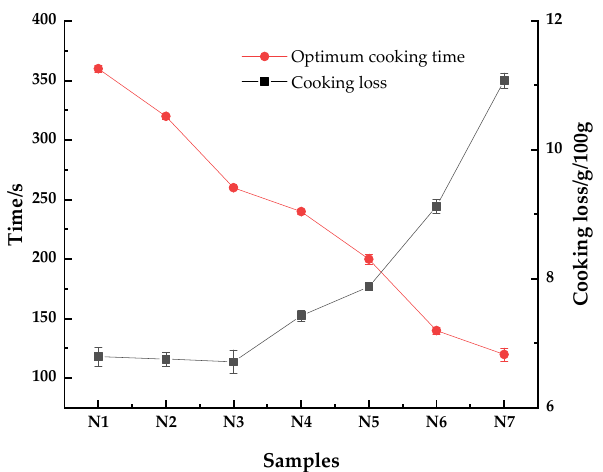
Figure 2. Cooking properties of the tartary buckwheat noodles. N1–N7 respectively represent noodles with 0%, 10%, 20%, 30%, 40%, 50%, and 60% HTBF.